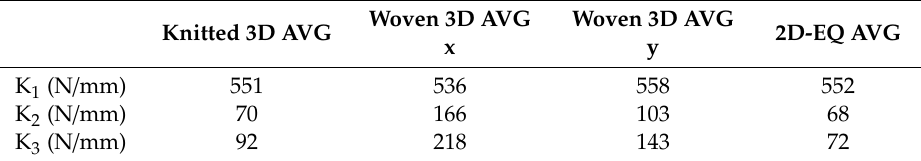
Table 8. Averaged sti ff ness in three stages in bending for all layups.